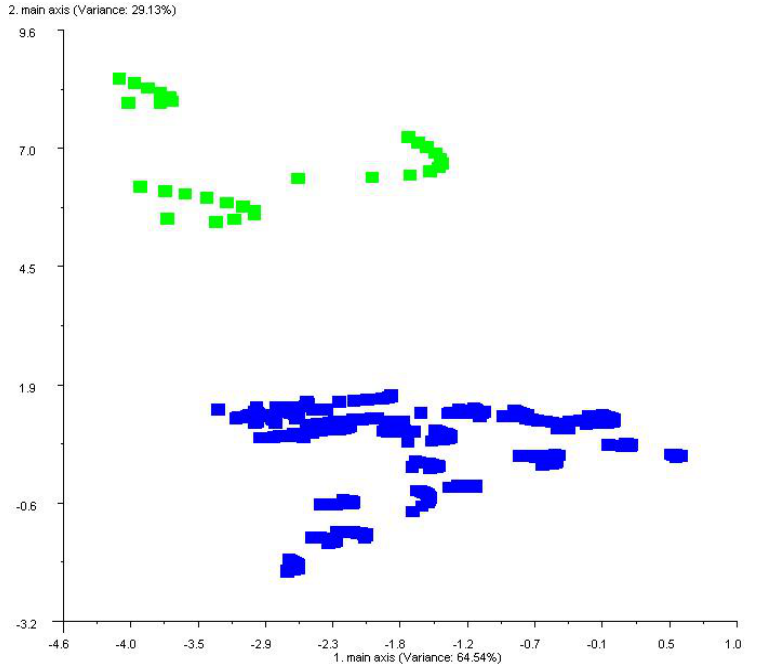
Figure 6. Discrimination of healthy (controls) and decayed (artificially inoculated) wood blocks samples by PCA based on differences in analyte principal components within headspace volatiles relative to standard deviations from the mean ( Δσ ). Color-coded labels are as follows: Green labels indicate volatiles from healthy, undecayed controls and blue labels indicate volatiles from decayed wood